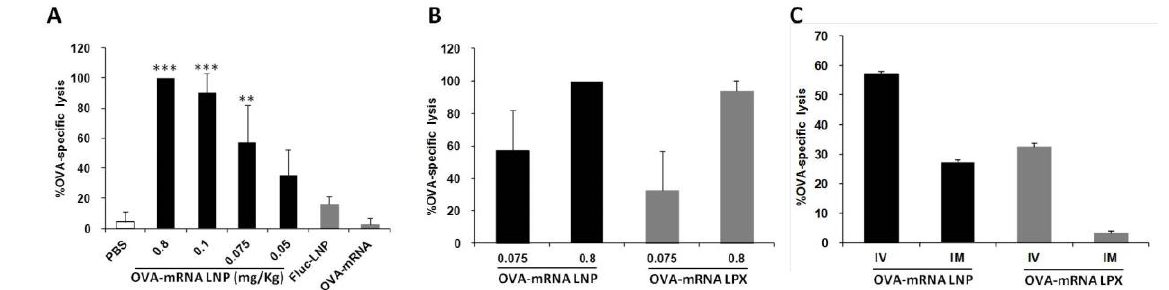
Figure 4. CTL analysis after administration of different doses of mRNA formulations using different routes of administration. ( A ) OVA-specific CTL activity measured after treatment with different doses of OVA-mRNA LNP. LNP encapsulating luciferase gene (Fluc-LNP) or naked OVA mRNA were used as controls at a dose of 0.8 mg/kg (*** p < 0.001, ** p < 0.01, vs. PBS, Fluc-mRNA LNP and naked OVA-mRNA, Tukey-Kramer). ( B ) Comparison of OVA-specific CTL activity between OVA-mRNA LNP and RNA-LPX using different dose. ( C ) Comparison of OVA-specific CTL activity between IV and IM injection of OVA-mRNA LNP and RNA-LPX. The administered dose was 0.075 mg/kg.